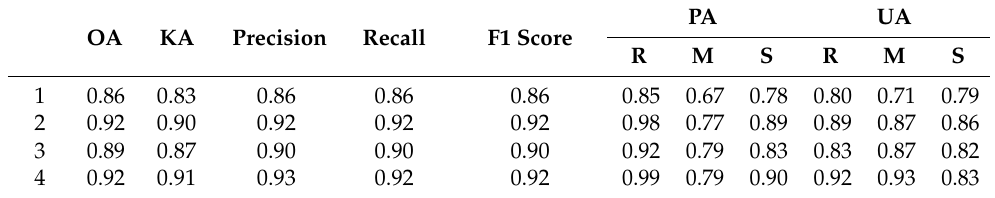
Table 6. Accuracy assessment of crop classification for the IO-Growth method with participation of different features. Note that numbers of tests are explained.